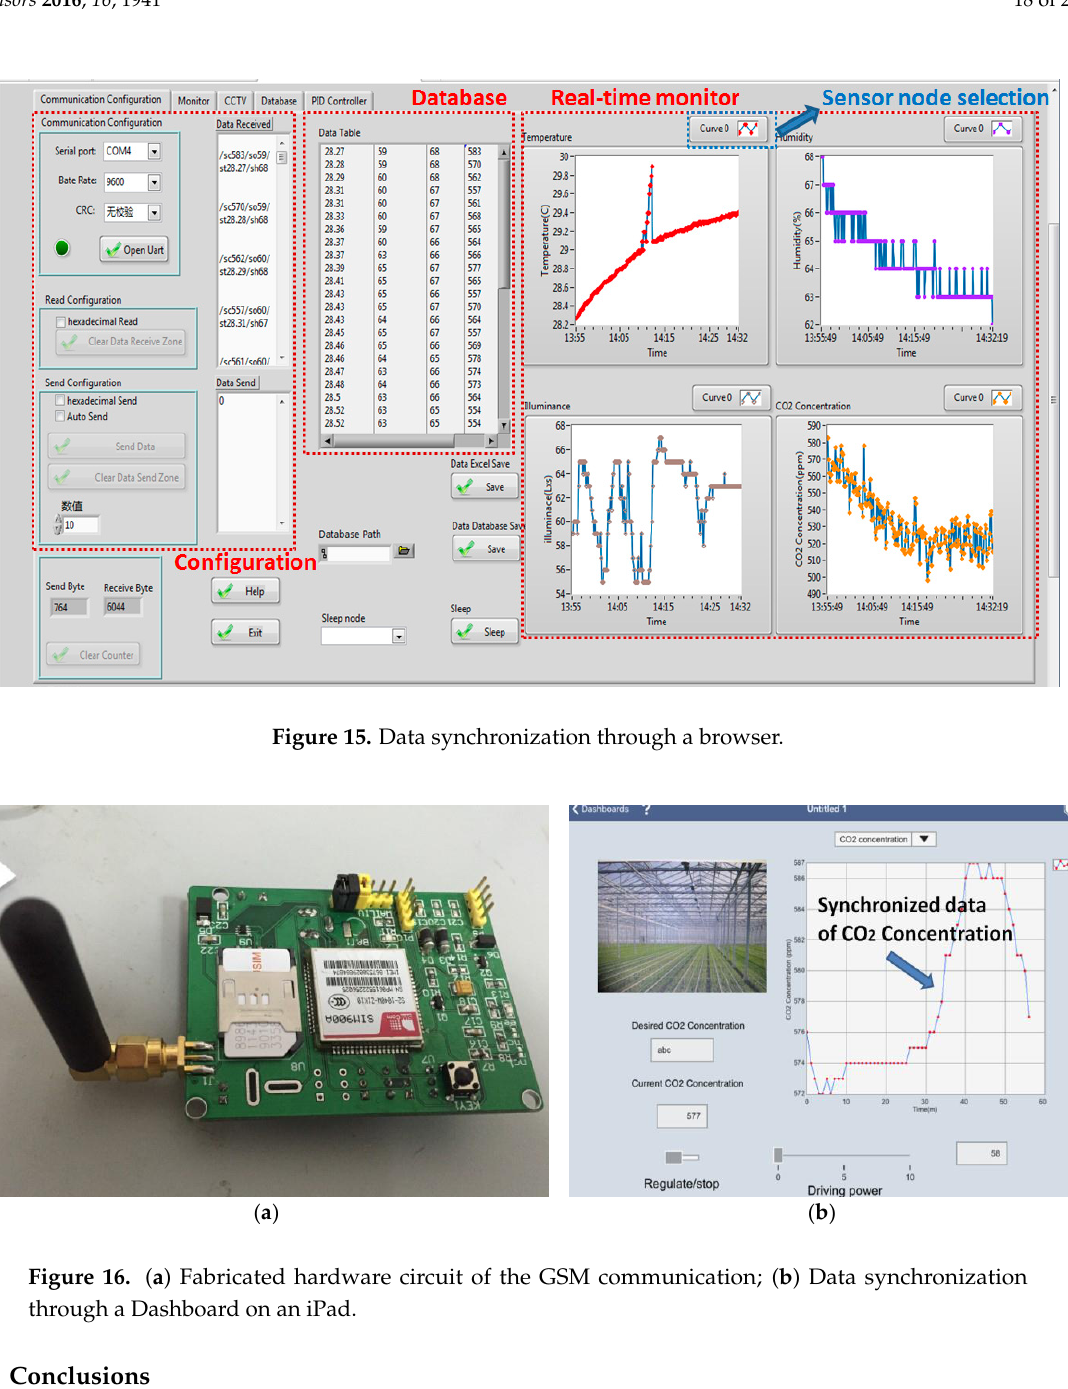
Figure 16. ( a ) Fabricated hardware circuit of the GSM communication; ( b ) Data synchronization through a Dashboard on an iPad.